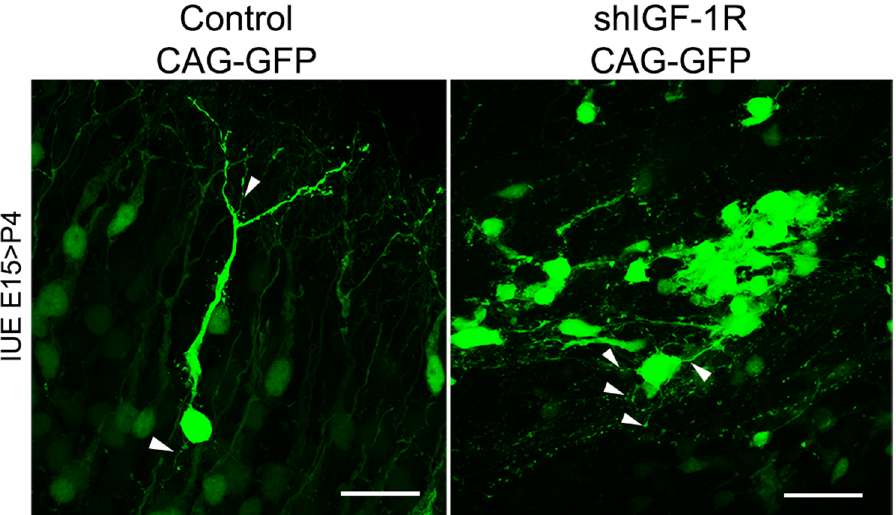
Figure 7. IGF-1R suppressed neurons remain as multipolar cells even at P4. Cells arrested in the VZ/SVZ/IZ in brains electroporated with the shRNA- IGF-1R and analyzed at P4 are mainly multipolar cells arranged in heterotopic groups (right). Control cells in layers II-IV show normal differentiation with a ramified dendrite (arrowhead) and a trailing axon (left). Calibration bar = 10 μ